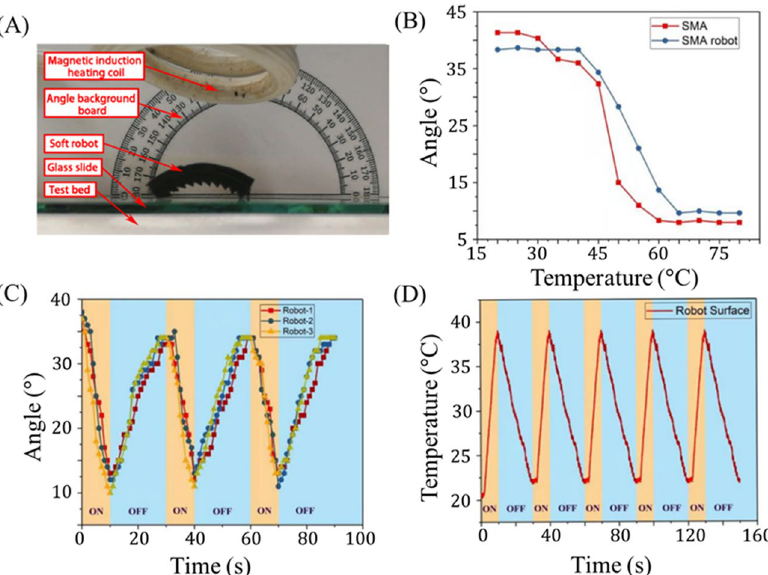
Figure 3. Magnetothermal response behavior of SMA mag-bot. ( A ) The experimental setup used to measure magnetothermal response of the mag-bot is shown. ( B ) The average bending angle response of three mag-bot prototypes (blue circles) and three SMA skeletons (red squares) is plotted with respect to temperature. ( C ) Deformation angle is plotted with respect to time for three mag-bots undergoing three periods of reversible loading (each). ( D ) Average surface temperature of three mag-bots is plotted with respect to time for five periods of thermal